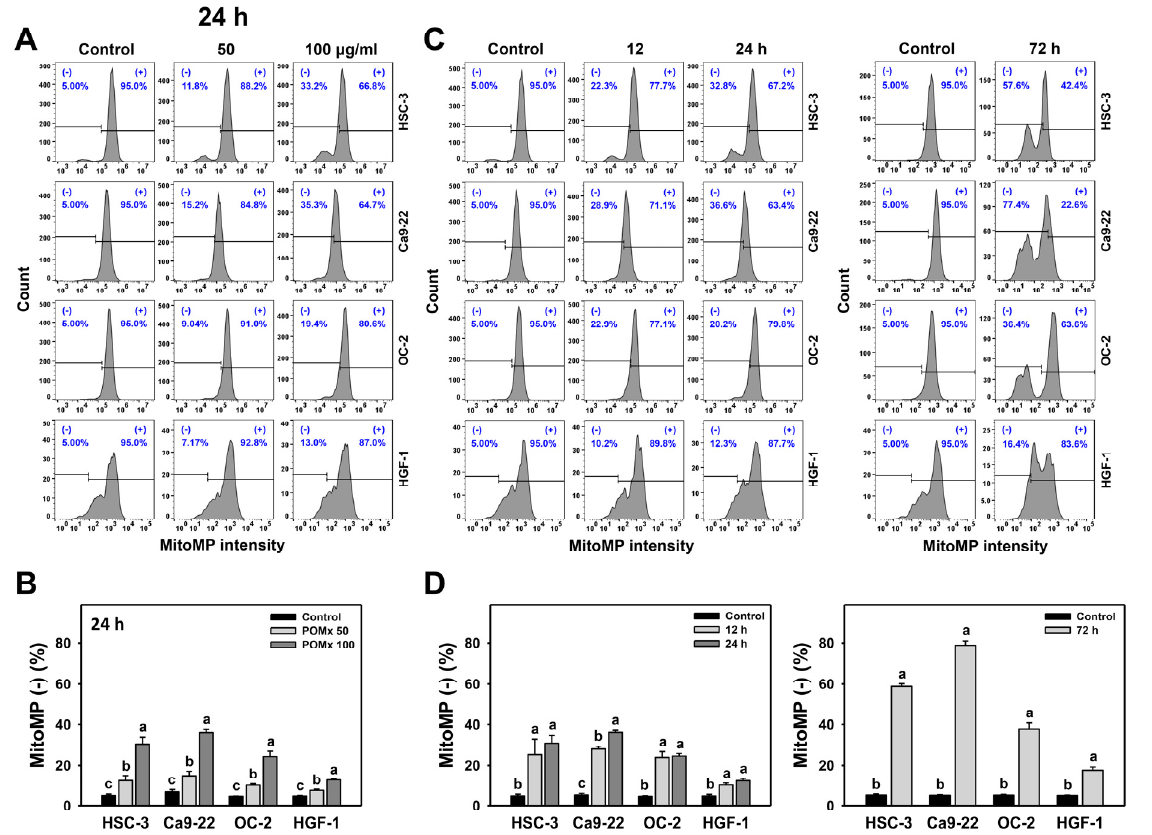
Figure 5. MitoMP change of oral cancer cells after POMx incubation. ( A ) Dose-response to MitoMP flow cytometry patterns. Cells (HSC-3, Ca9-22, and OC-2) were incubated with control, 50, and 100 μ g/mL of POMx (control, POMx 50, and POMx 100) for 24 h. The MitoMP-negative ( − ) population was defined on the left part. ( B ) Statistics for ( A ). ( C ) Time course to MitoMP flow cytometry patterns. Cells were incubated with control and 100 μ g/mL of POMx for 0, 12, 24, and 72 h. ( D ) Statistics for ( C ). Treatments without overlapping low cases (a to c) represent significant differences for the same cell lines. p < 0.01. Data, mean ± SD ( n = 3).